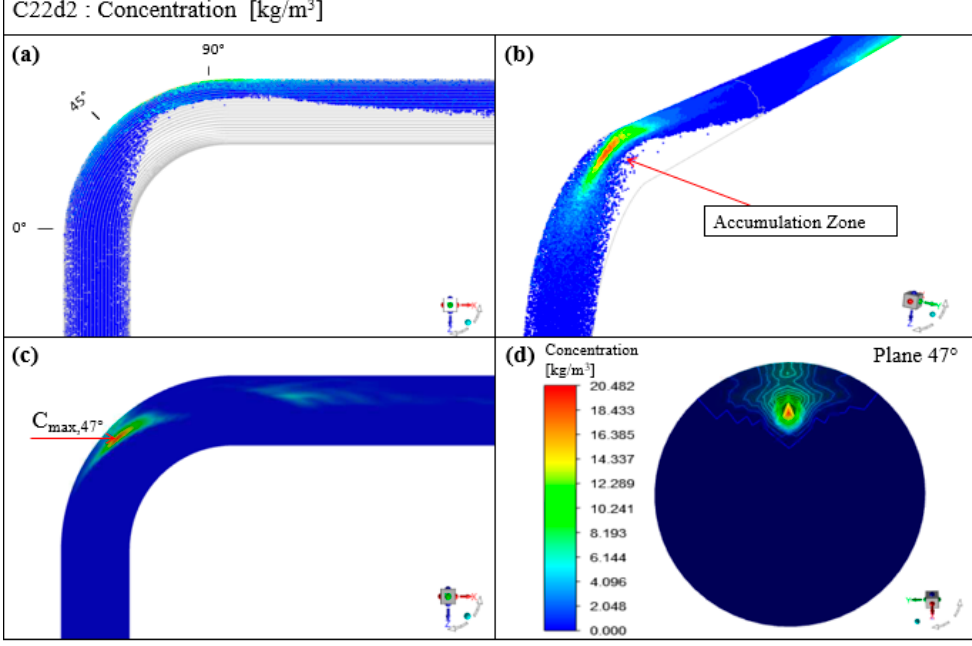
Figure A11. Results of particle concentration. Case C22d2. ( a ) Instant positioning of the X-Z plane particles ( b ) Instant positioning of the particles in 3D view ( c ) Concentration contour in the X-Z plane of the mid-section of the pipe ( d ) Concentration contour in the Z-Y plane of the maximum concentration cross section. Snapshots are taken for a statistically steady flow.